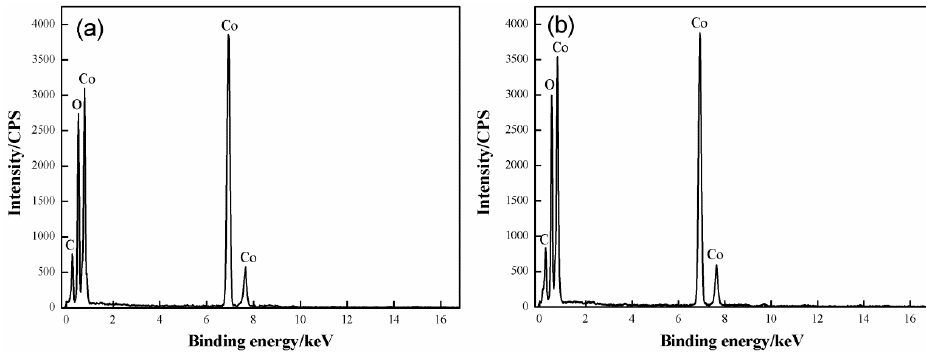
Figure 4. EDS results of the samples: ( a ) sample D; ( b ) sample F.